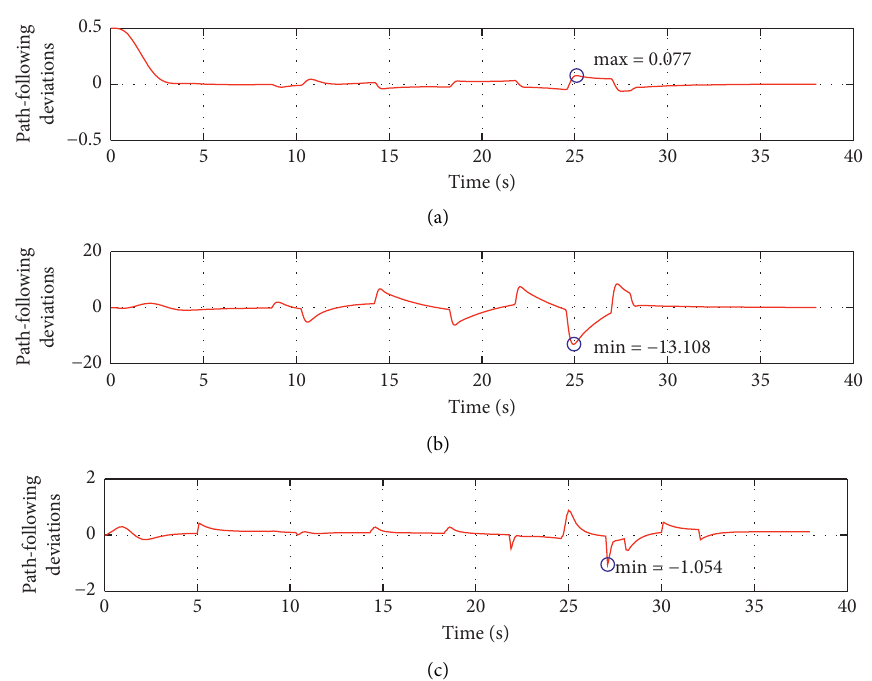
Figure 4: Time histories of path-following deviations of the vehicle under control. (a) Lateral deviation (m). (b) Heading deviation (deg). (c) Velocity deviation